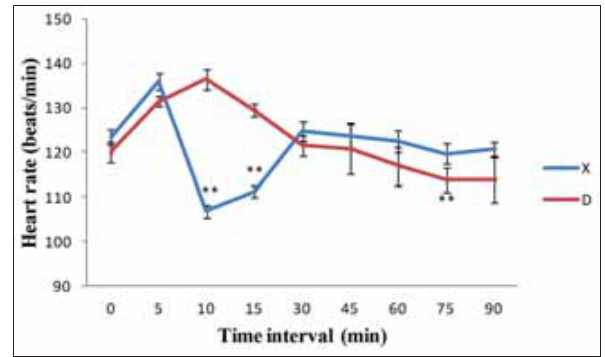
Figure-5: Mean±Standard error values of heart rate in animals of different groups. *Significantly different from the base value (p<0.05). **Significantly different from the base value